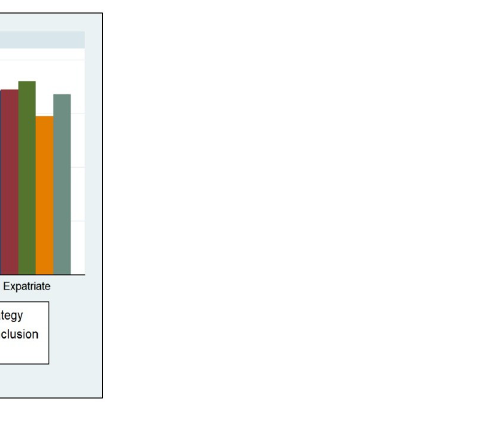
Fig 4. Status and critical thinking